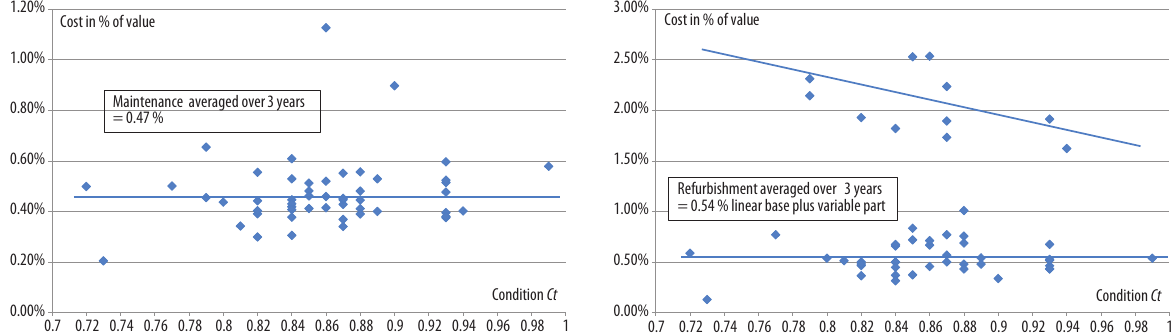
Fig. 5. The maintenance and the refurbishment signatures of the 60 buildings of the EPFL showing average annual costs in percentage of the building reinstatement values over the 3 years period from 2008 to 2010 in function of the building condition C according to Stratus (Note: the buildings form part of the portfolio shown in Figure 3)